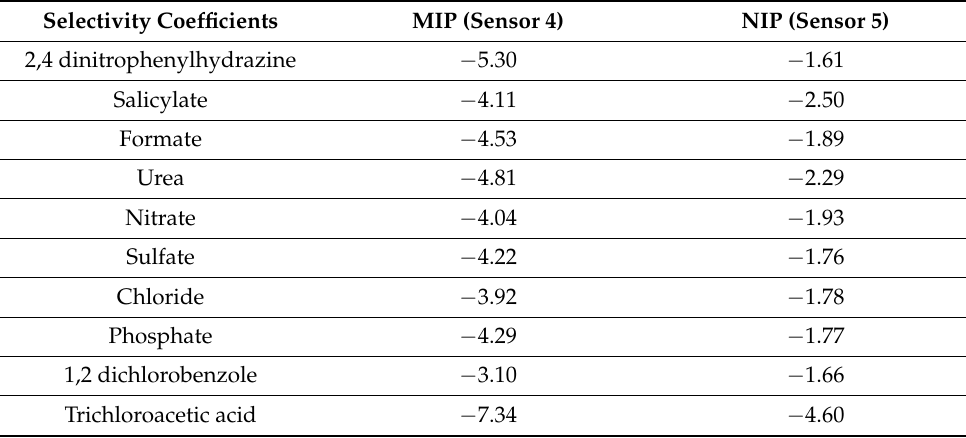
Figure 9. Selectivity of sensors 4 ( a ), sensor 5 ( b ) versus different types of interfering species measured in Tris buffer (pH = 7.0) at 25 °C. Table 3. Selectivity coefficient of MIP and NIPs for 2,4-D and the interfering species.